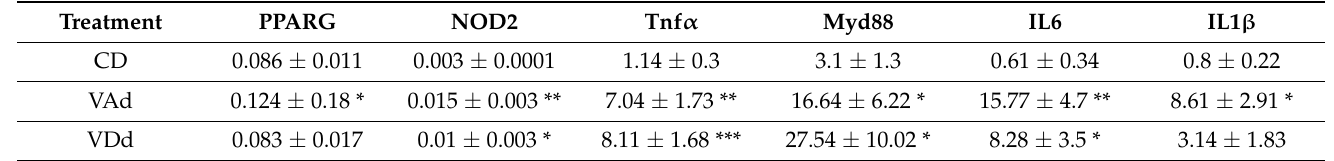
Table 2. Inflammatory markers measured in the colon